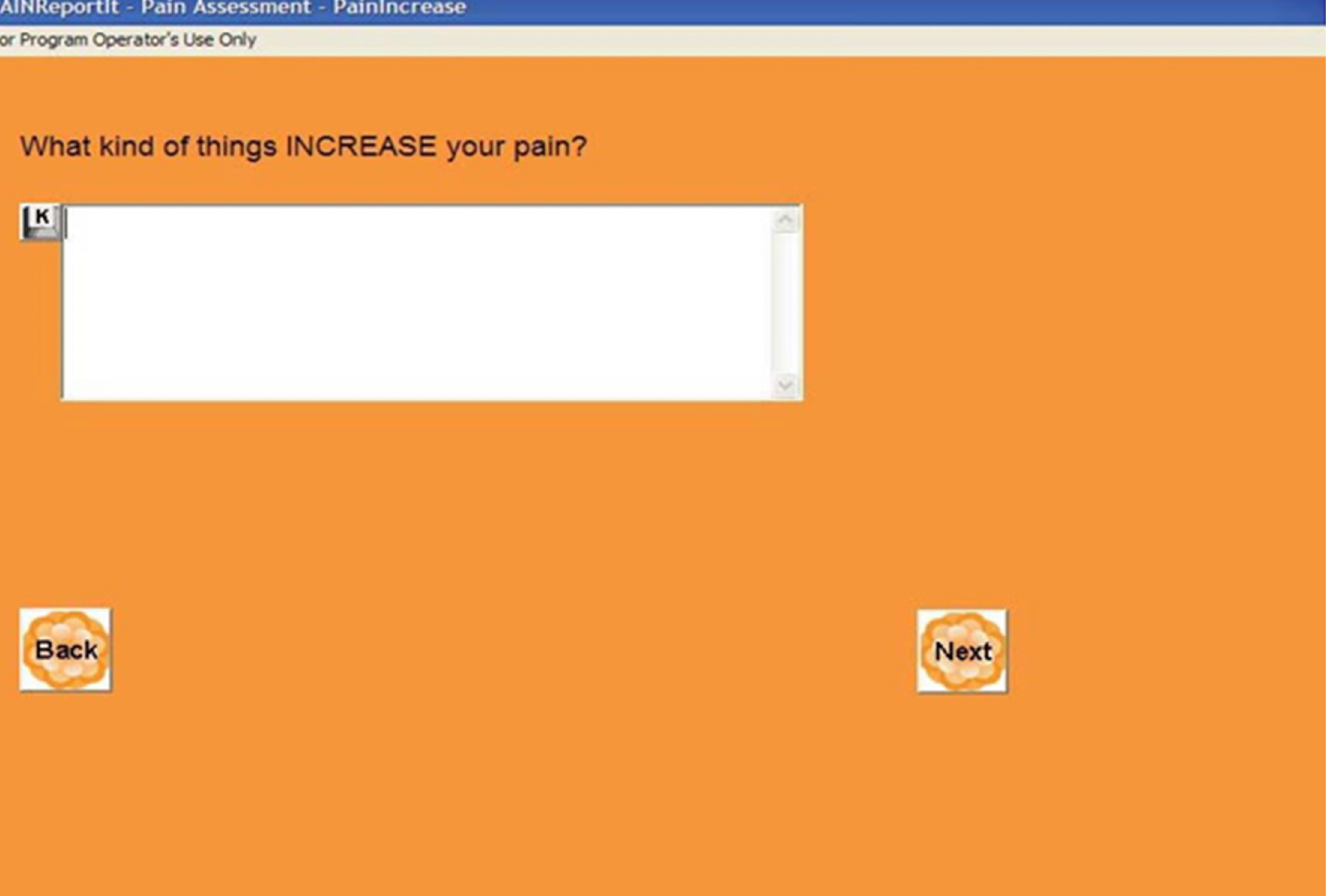
Fig 1. PAIN Report It item used to identify spontaneous report of stress as an aggravator of pain.